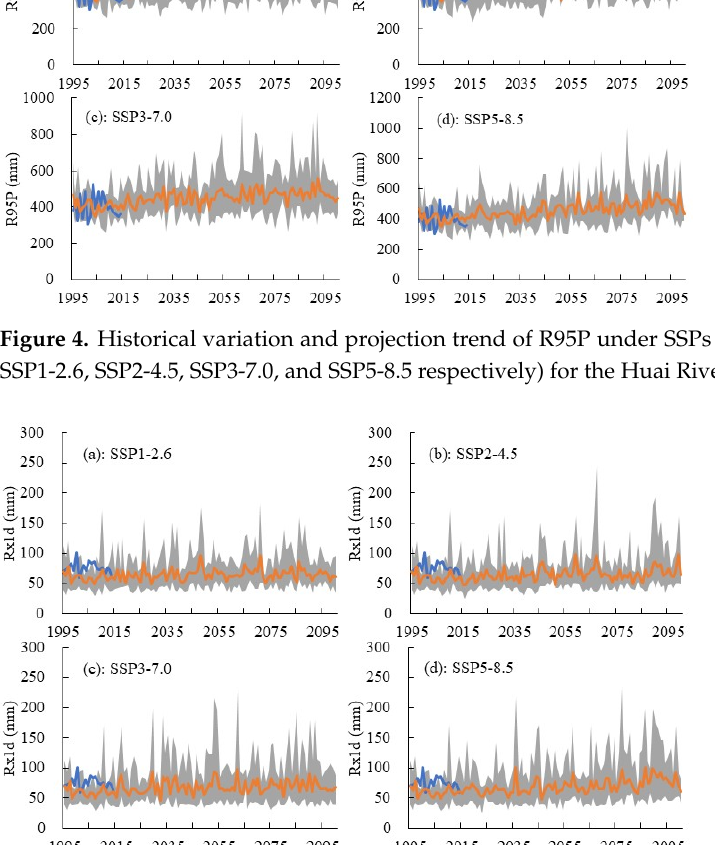
Figure 6. Historical variation and projection trend of Rr50 under SSPs scenarios (a to d represent SSP1 ‐ 2.6, SSP2 ‐ 4.5, SSP3 ‐ 7.0, and SSP5 ‐ 8.5 respectively) for the Huai River basin (same to Figure 2). Table 4. Tendency rate and M ‐ K statistics of extreme rainfall index under SSPs scenarios in the Huai River basin. Scenarios